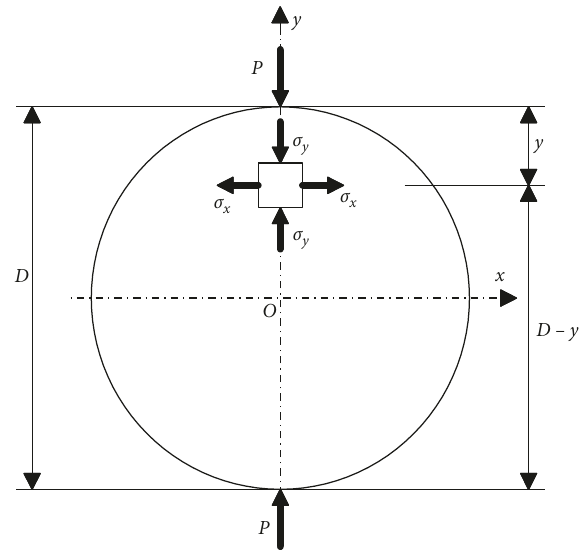
Figure 6: Brazilian disc test